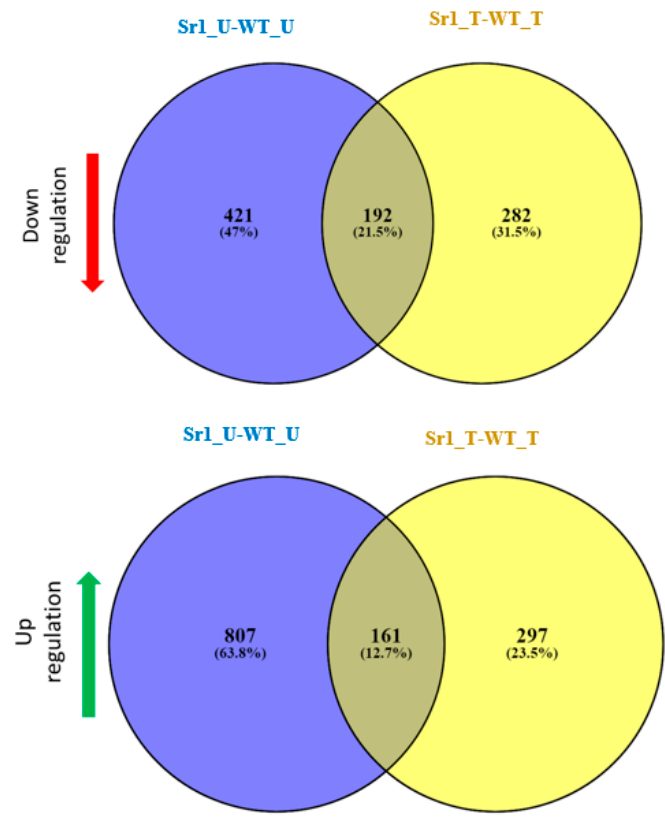
Figure 2. Comparative analyses of transcriptomes in WT and atsr1 . Venn diagram of a double-sided comparison of microarray expression data revealing the circles which represent total number and arrows which represent the number of differentially expressed genes (DEGs) between the genotype test or pathogen inoculation. 192 genes were observed that are down-regulated with a fold change (FC) ≤ − 2 and p -value < 0.05 in both of the tests, and 161 genes were observed to be up-regulated with an FC ≥ 2 and p -value < 0.05 in both of the tests. WT_U: WT untreated; WT_T: WT treated with pathogen infection for 24 h after infiltration with Pst DC3000; Sr1_U: sr1 untreated; Sr1_T: Sr1 treated with pathogen infection for 24 h after infiltration with Pst